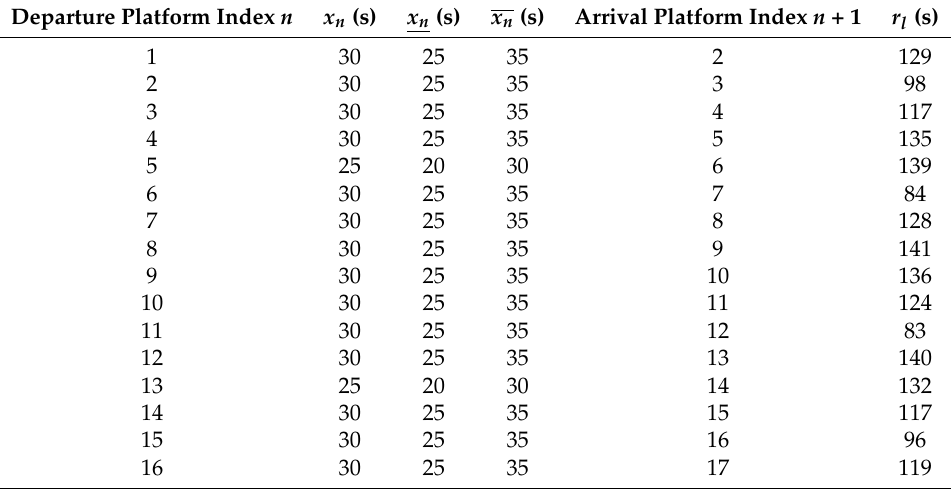
Table 1. Actual dwell time and running time of Yanfang